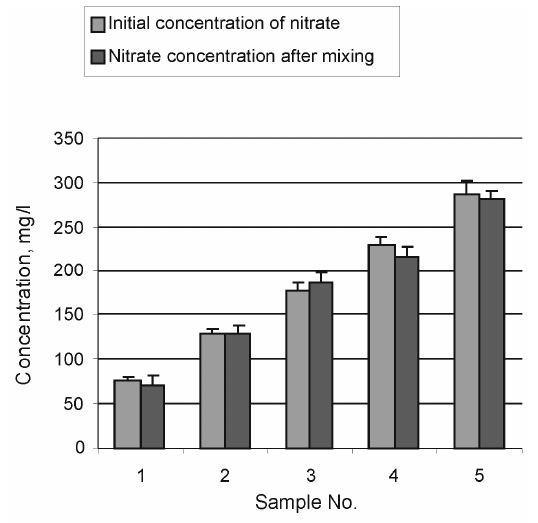
Fig. 2. Variation range of nitrate concentrations